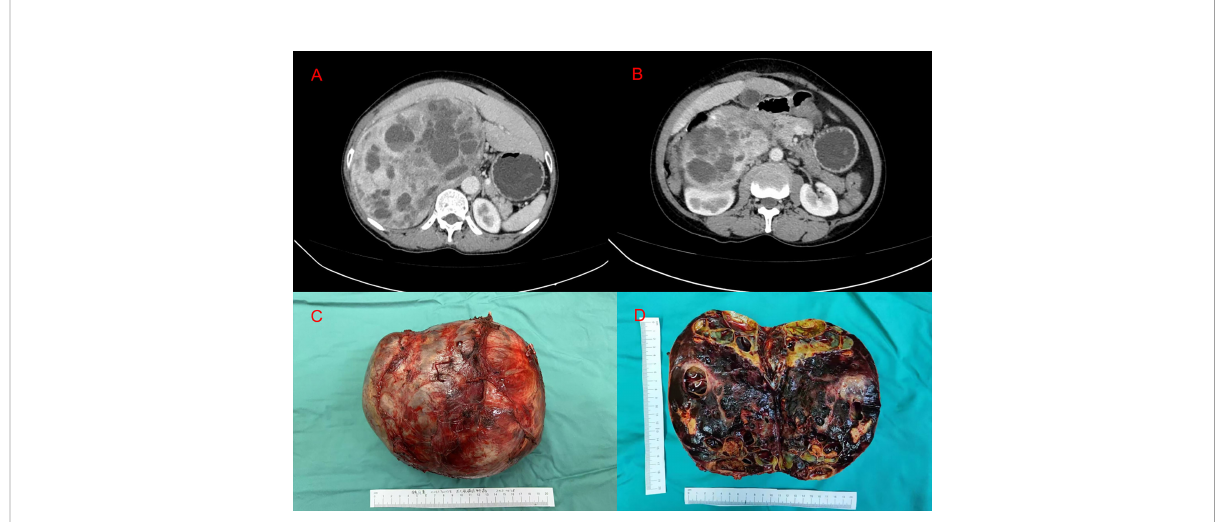
FIGURE 1 (A, B) Abdominal enhanced computed tomography imaging representing the huge tumor between the right lobe of the retroperitoneal liver and the right kidney. (C) A macroscopic image of the post-section cystic pheochromocytoma. (D) Excised tumor, measuring 20 × 15 × 10